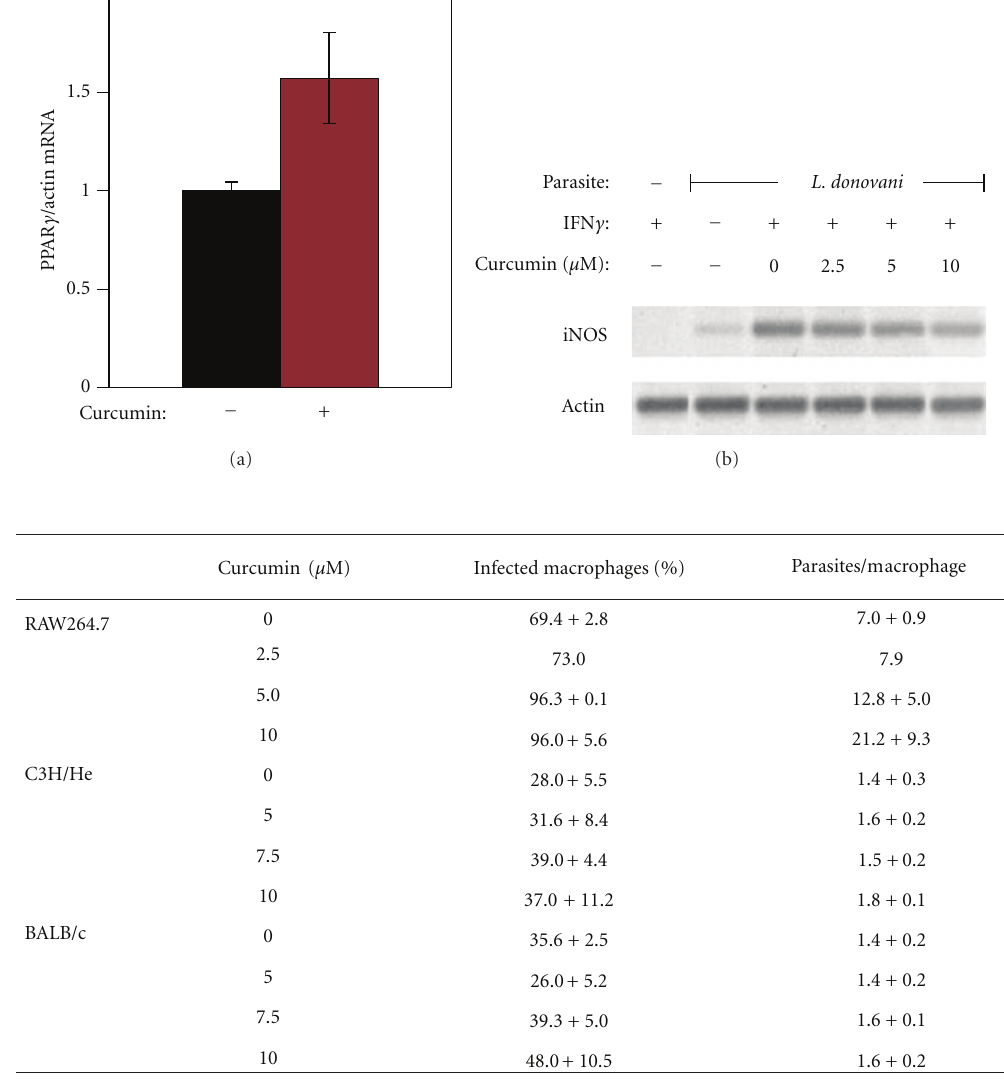
Figure 7: Curcumin induces PPAR γ mRNA expression and reduces iNOS mRNA expression in infected macrophages. In (a), PECs of BALB/c mice were infected with L. donovani promastigotes, and then 10 μ M of curcumin (brown bar) or vehicle control (0.1% acetone) was added. After 2 days, the cells were harvested for RNA isolation to determine the level of PPAR γ and β -actin expression by real-time RT-PCR. In (b), murine RAW264.7 cells were infected with L. donovani for 16–20 hours. Then, di ff erent concentrations of curcumin were added. Thirty minutes after curcumin treatment, IFN γ was added to activate the macrophages. At 5 hours after the addition of IFN γ , the cells were harvested, mRNA was extracted, and conventional RT-PCR was performed. The gel shows the end point PCR-amplified iNOS (496bp) and β -actin cDNAs products. In (c), nonelicited PECs from resistant C3H and susceptible BALB/c strains were cultured with L. donovani promastigotes in wells that contained cover slips for a period of 16–20 hours; then curcumin and IFN γ and TNF α were added. On day 4-5, the coverslips were stained to enumerate the percent of infected macrophages and number of amastigotes per macrophage under a microscope, similar to steps described in Figure